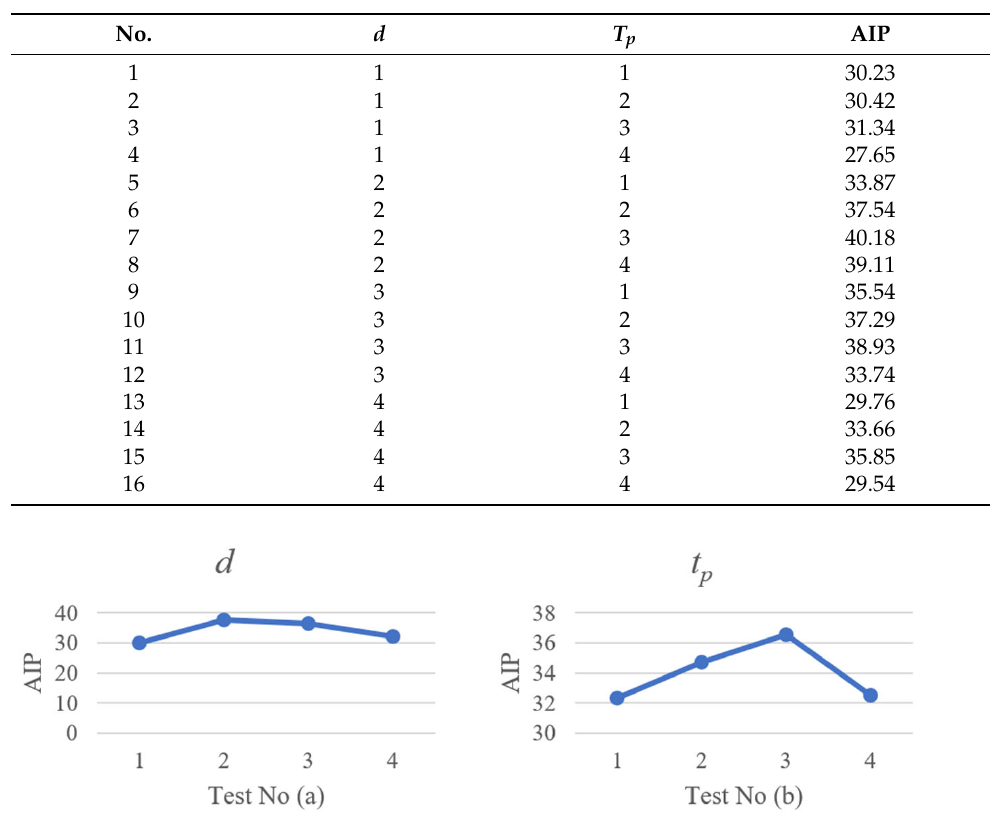
Table 4. Results of the orthogonal test.